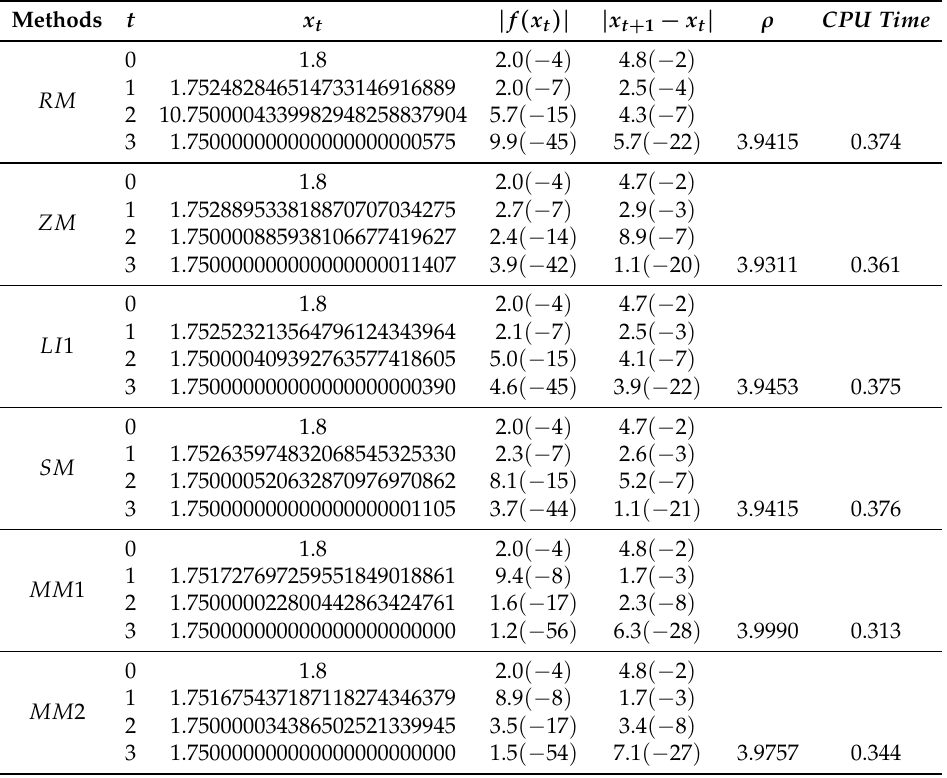
Table 1. Outcomes for comparison by testing schemes on Example